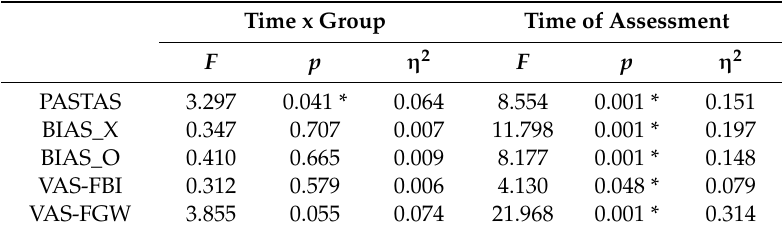
Table 2. Mixed between–within subject analysis of variance comparing groups (Group 1-Asynchronous group versus Group 2-Synchronous group) with the di ff erent assessment conditions.